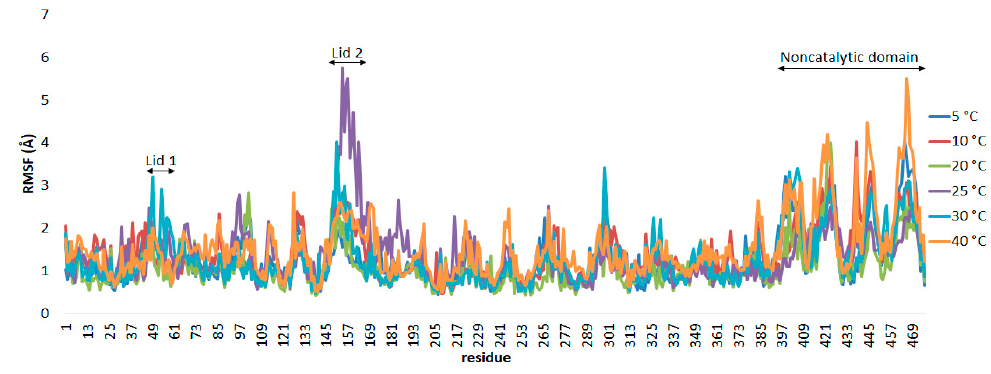
Figure 4. Root mean square fluctuations (RMSf) per residue of the AMS8 atoms.